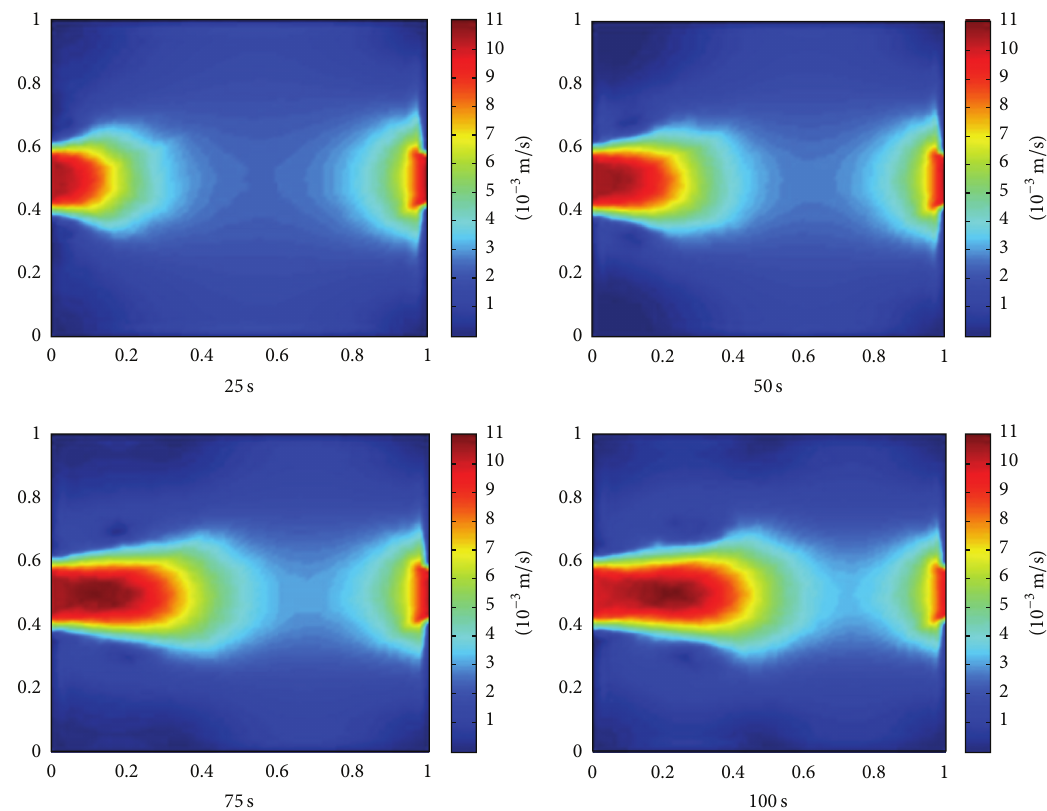
Figure 4: Velocity field of the free-flow region at different